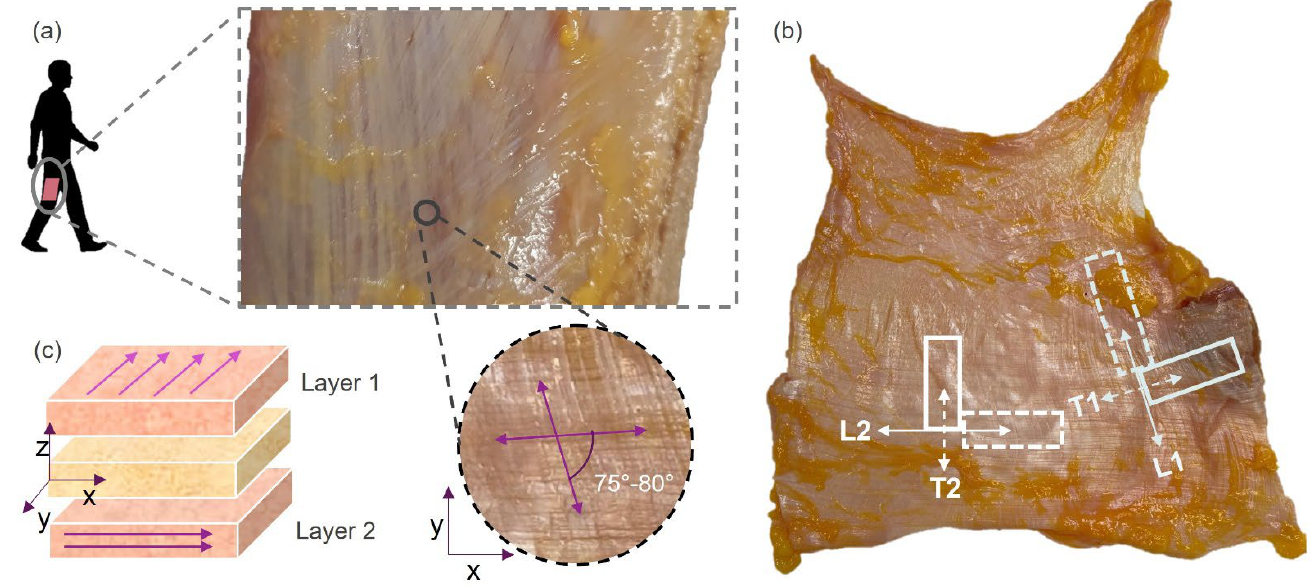
Figure 1. ( a ) Origin of the harvested specimens and histological evidence of the interlayer angle. ( b ) Example of harvested samples from one subject: numbers 1 or 2 refer to layers 1 or 2, while letters L or T refer to sample cutting longitudinal to the fibers or transversal to the fibers. Horizontal direction approximately corresponds to the cranio-caudal direction. ( c ) The multilayer structure and layer orientations.